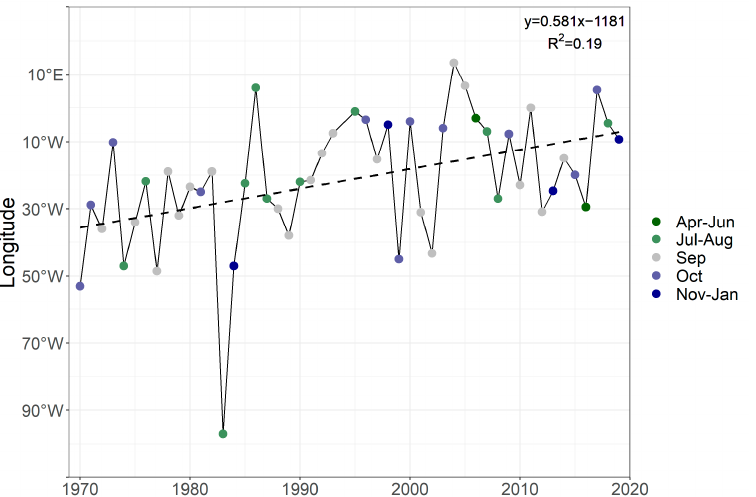
Figure 4. Multiannual changes in the maximum longitude reached in a given year by the easternmost ETC in the North Atlantic over the 1970–2019 period, with months taken into account.